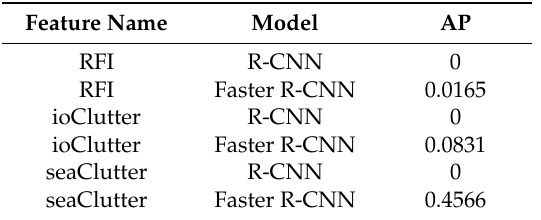
Figure 6. Comparison between the original images and the Faster R-CNN detection examples as well as the R-CNN detection examples in ionospheric clutter, RFI and sea clutter: ( a – c ) show the different detection results in ionospheric clutter; ( d – f ) show the different detection results in RFI; ( g – i ) show the different detection results in sea clutter. Table 4. Average Precision of R-CNN and Faster R-CNN in RFI, Ionospheric Clutter and Sea Clutter